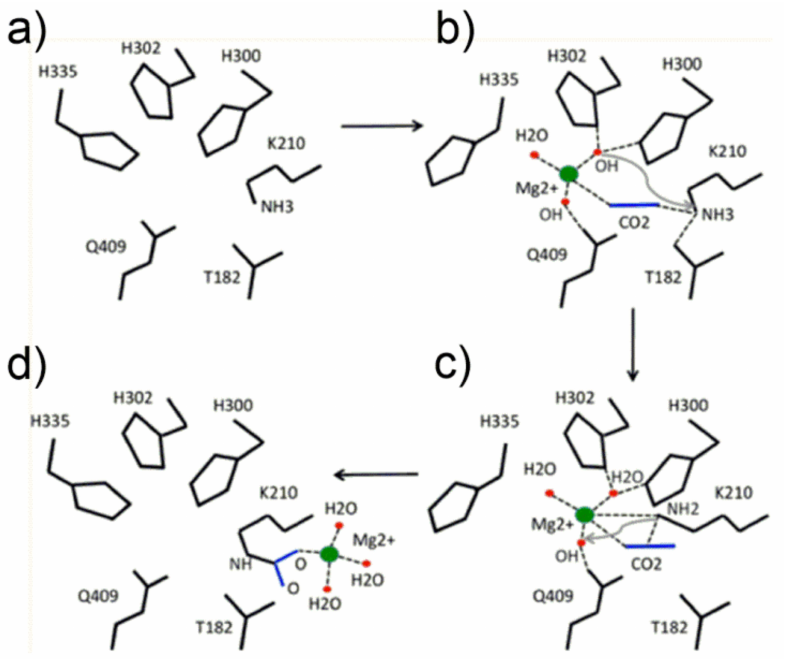
Figure 5. Mechanism of the Rubisco activation reaction as proposed by Stec. ( a ) Shows the arrange- ment of the His335 side chain contributing to the “activation binding site”; ( b ) shows that the His-335 side chain swings out to an alternative conformational state allowing a Mg 2+ ion binding; ( c ) after proton abstraction, Lys201 swings in a position close to the CO 2 -carbon affording the carbamylated- Lys201. The gray arrow shows the second OH − group abstracting H + from the NH 2 -carbamyl-moiety; ( d ) formation of a Mg 2+ -stabilized aci-carbamate complex reaching a new location and prone to start the catalytic reactions (Figure from ref. [15], used by permission of PNAS (copyright ©